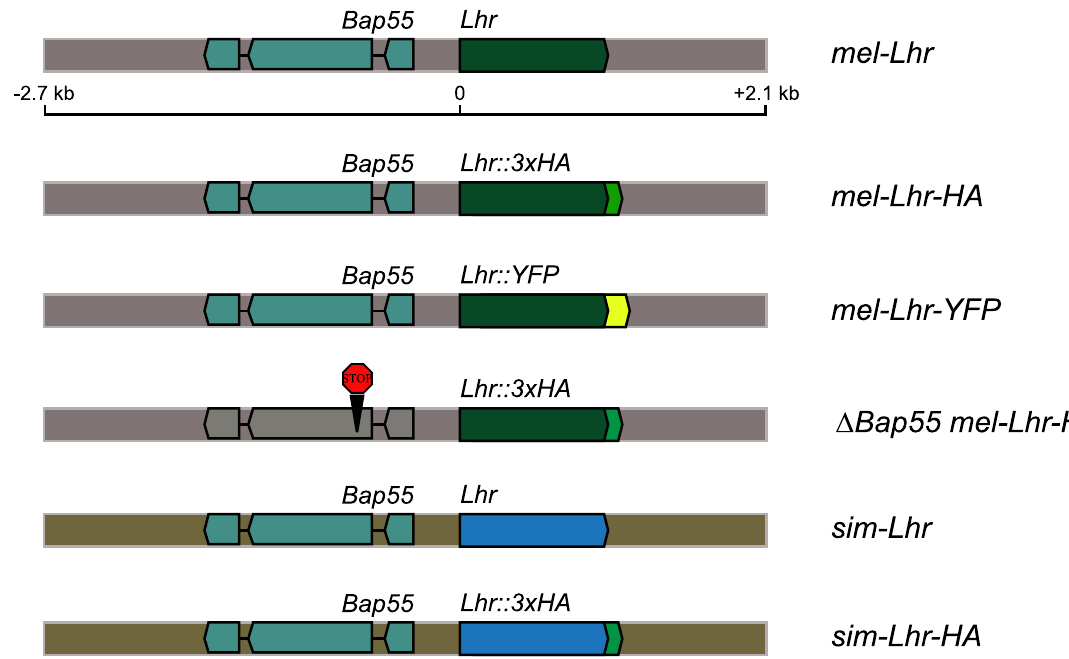
Figure 1. A schematic of the Lhr constructs. All constructs contain the full Lhr and Bap55 coding sequences and UTRs. The ‘‘stop’’ in D Bap55 mel- Lhr-HA represents the insertion of two stop codons and a frame shift mutation. The mel-Lhr and sim-Lhr constructs are drawn to proportion, the HA and YFP epitope tags in other constructs are not drawn to proportion.